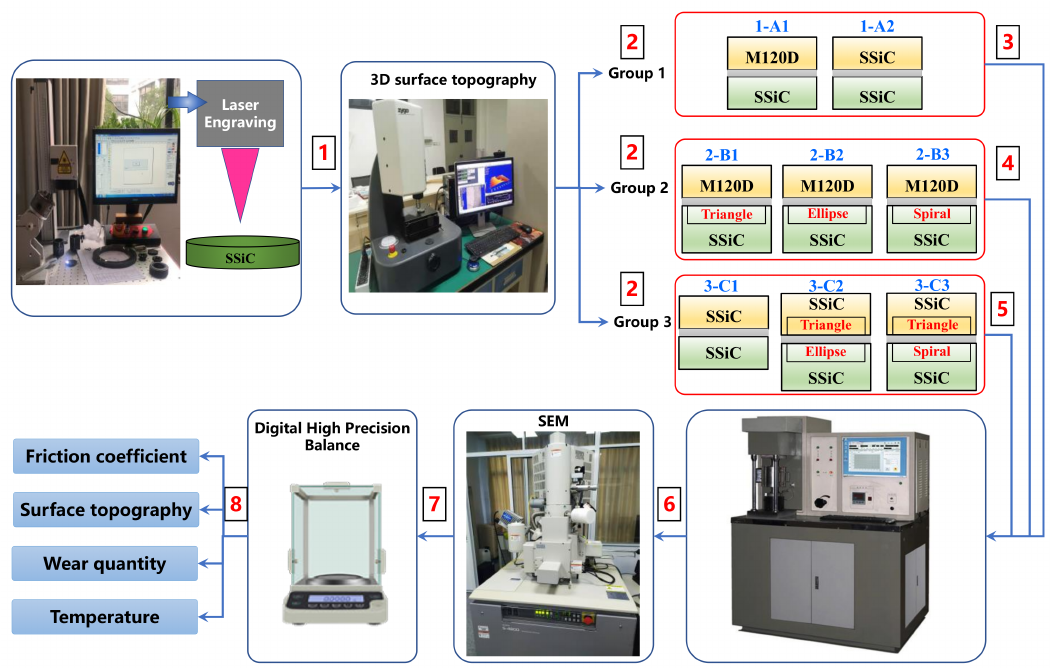
Figure 3. Test process of friction pairs with different materials and different surface